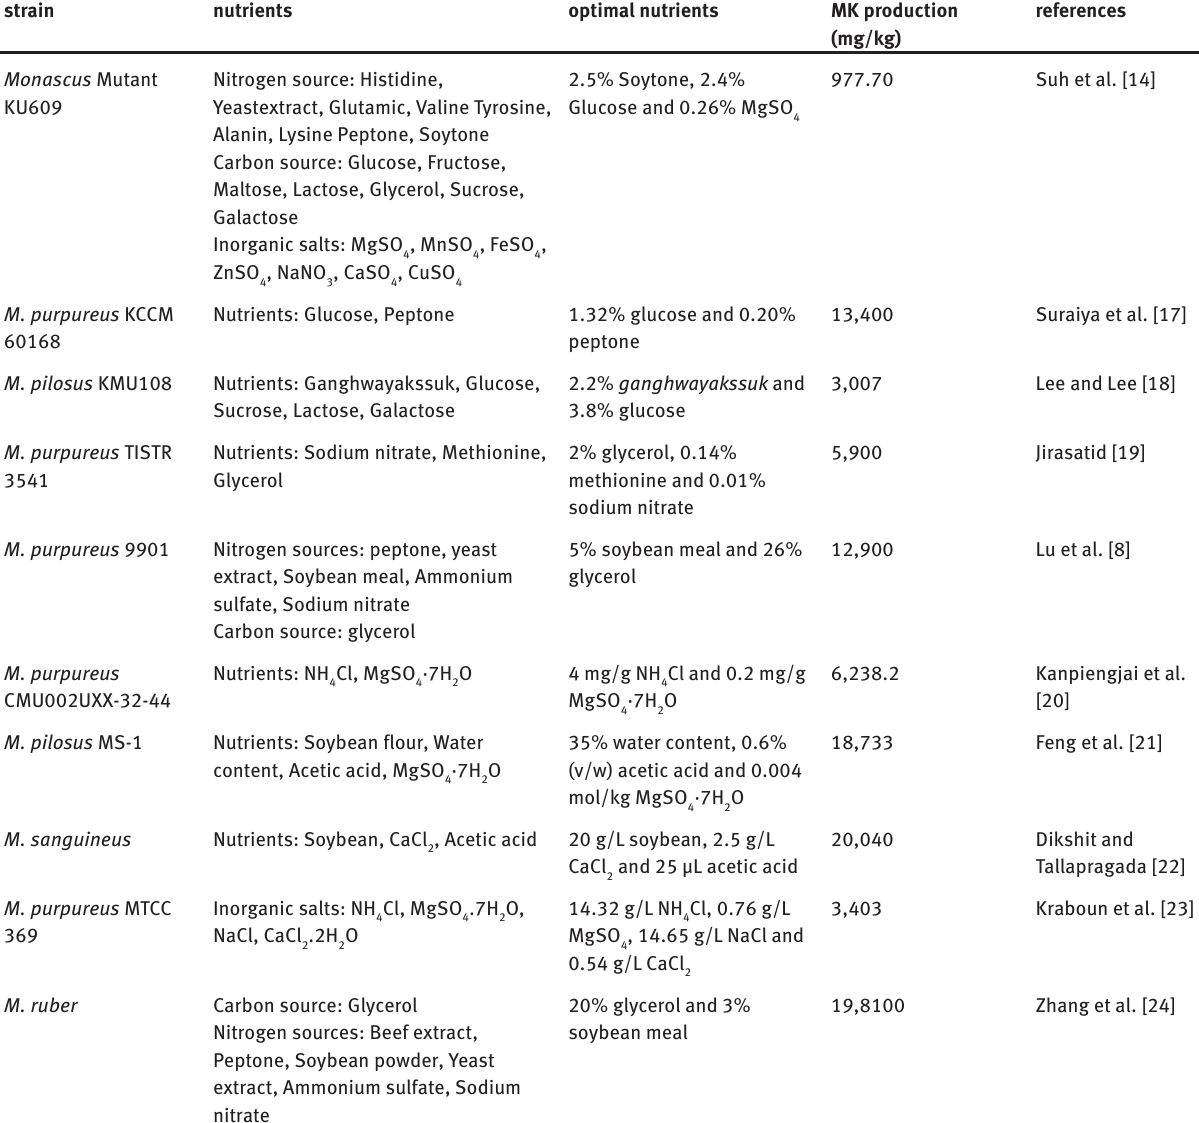
Table 1: Optimization of the SSF Medium Components of Monascus . strain nutrients optimal